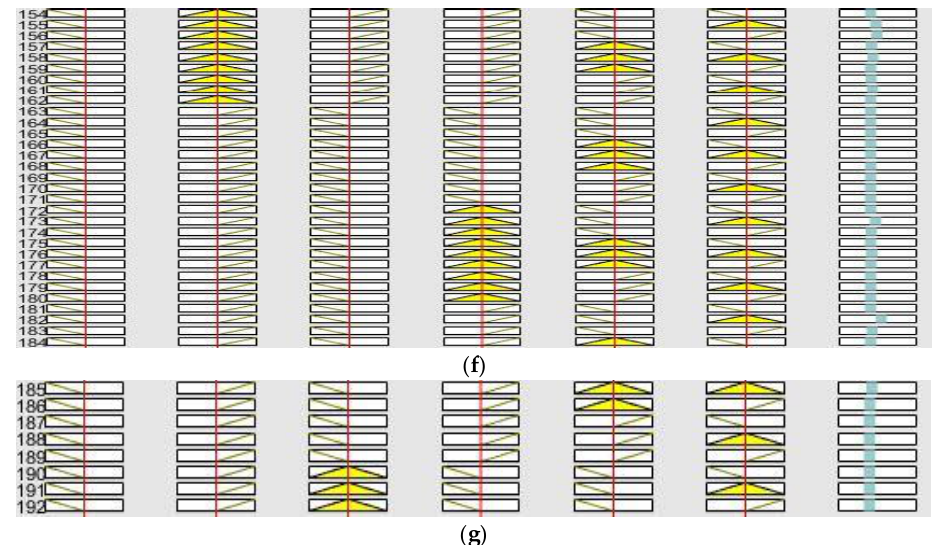
Figure 7. ANFIS modeling rules. ( a ) 1–29, ( b ) 30–60, ( c ) 61–91, ( d ) 92–122, ( e ) 123–153, ( f ) 154–184, ( g ) 185–192.